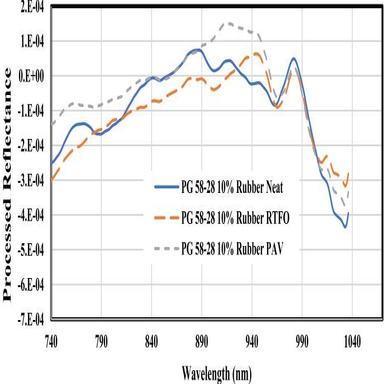
Comparison of the PG 58-28 binders with 10% rubber at different aging levels.